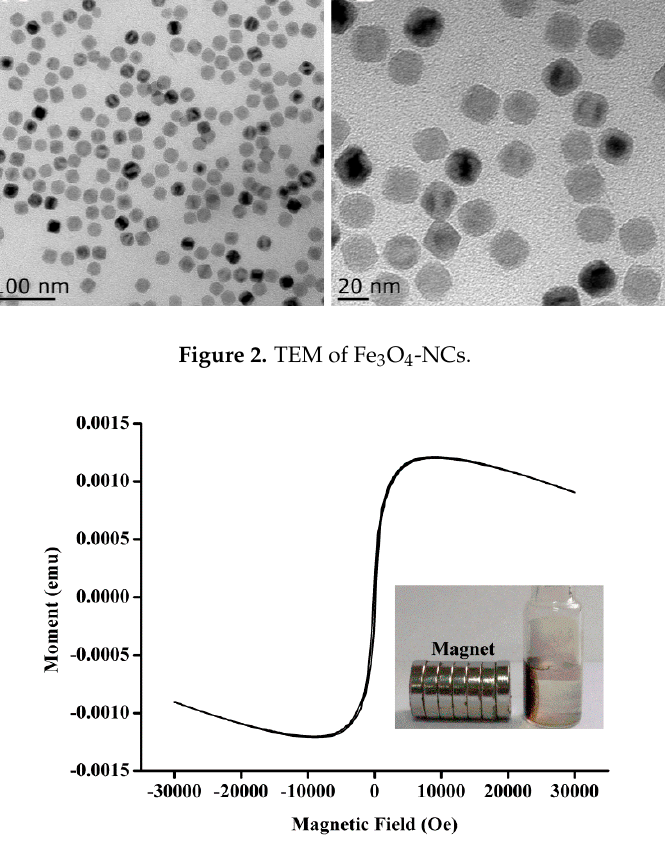
Figure 3. VSM magnetization curves of Fe 3 O 4 -NCs. The inset shows the separation of a solution of Fe 3 O 4 -NCs in the presence of an external magnetic field.